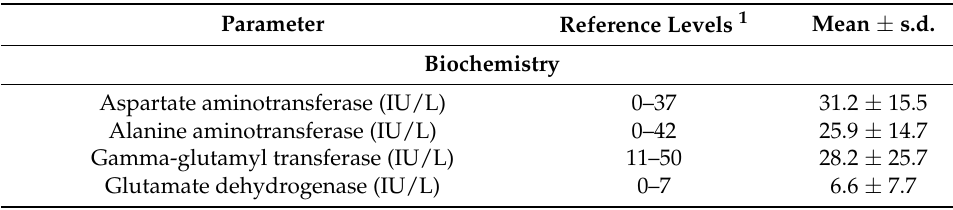
Table 4. The cohort blood